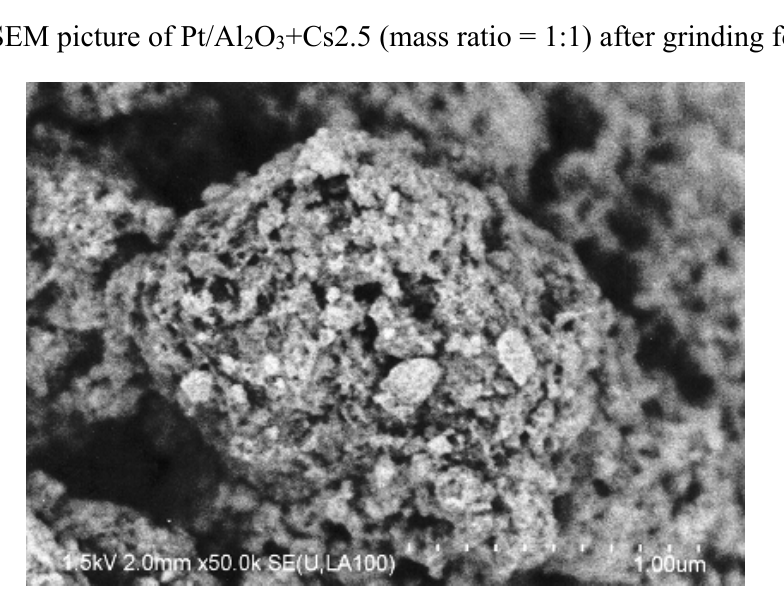
Figure 1. SEM picture of Pt/Al